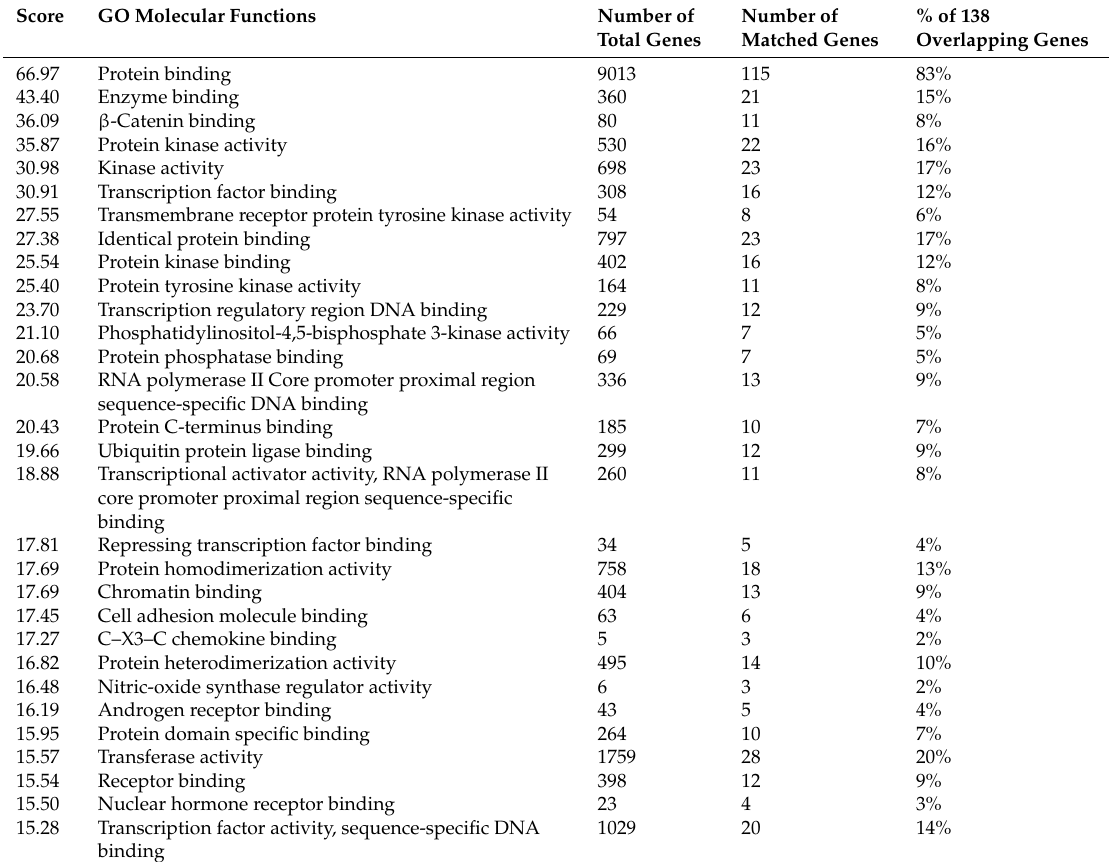
Table 4. Profiling of high scores in overlapping genes for autism and cancer-associated GO molecular